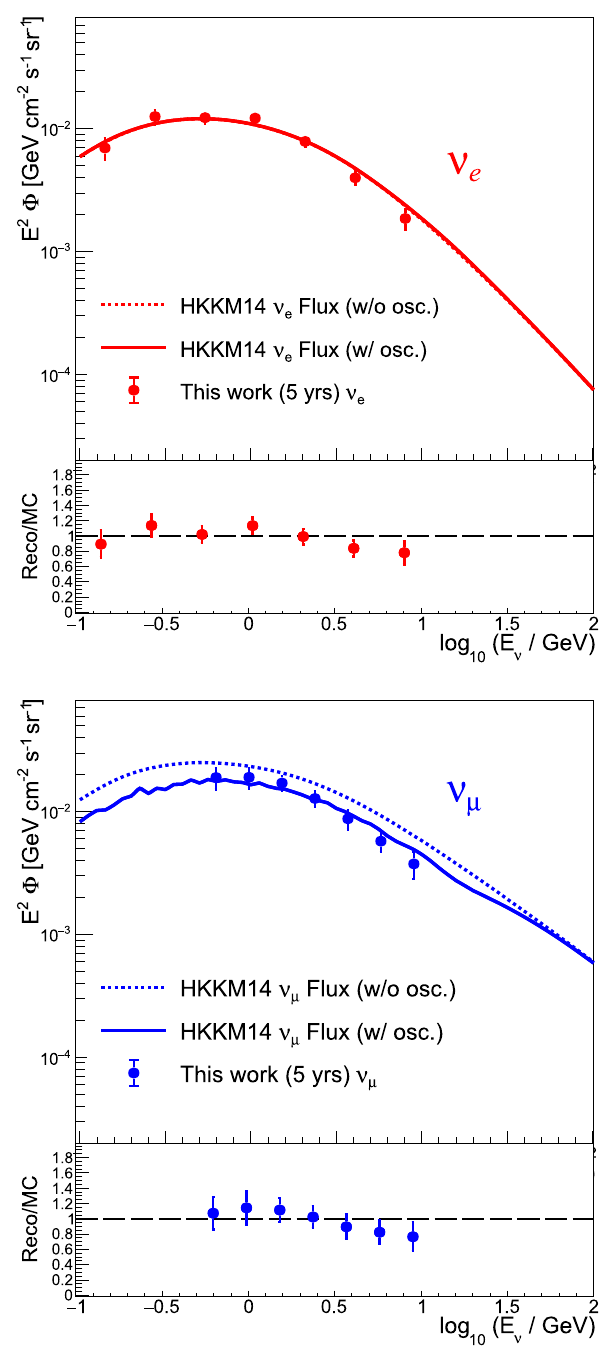
Fig. 9 Reconstructed energy spectra for the ν e (top) and the ν μ flux (bottom). The fluxes are plotted multiplied by E 2 , to give a better pic- ture. The error bars on the flux values include all statistical and system- atic contributions evaluated in Sect. 4.5. The HKKM14 flux prediction [33] is also reported, at the source (dashed line) and including the oscil- lation effects (full line)